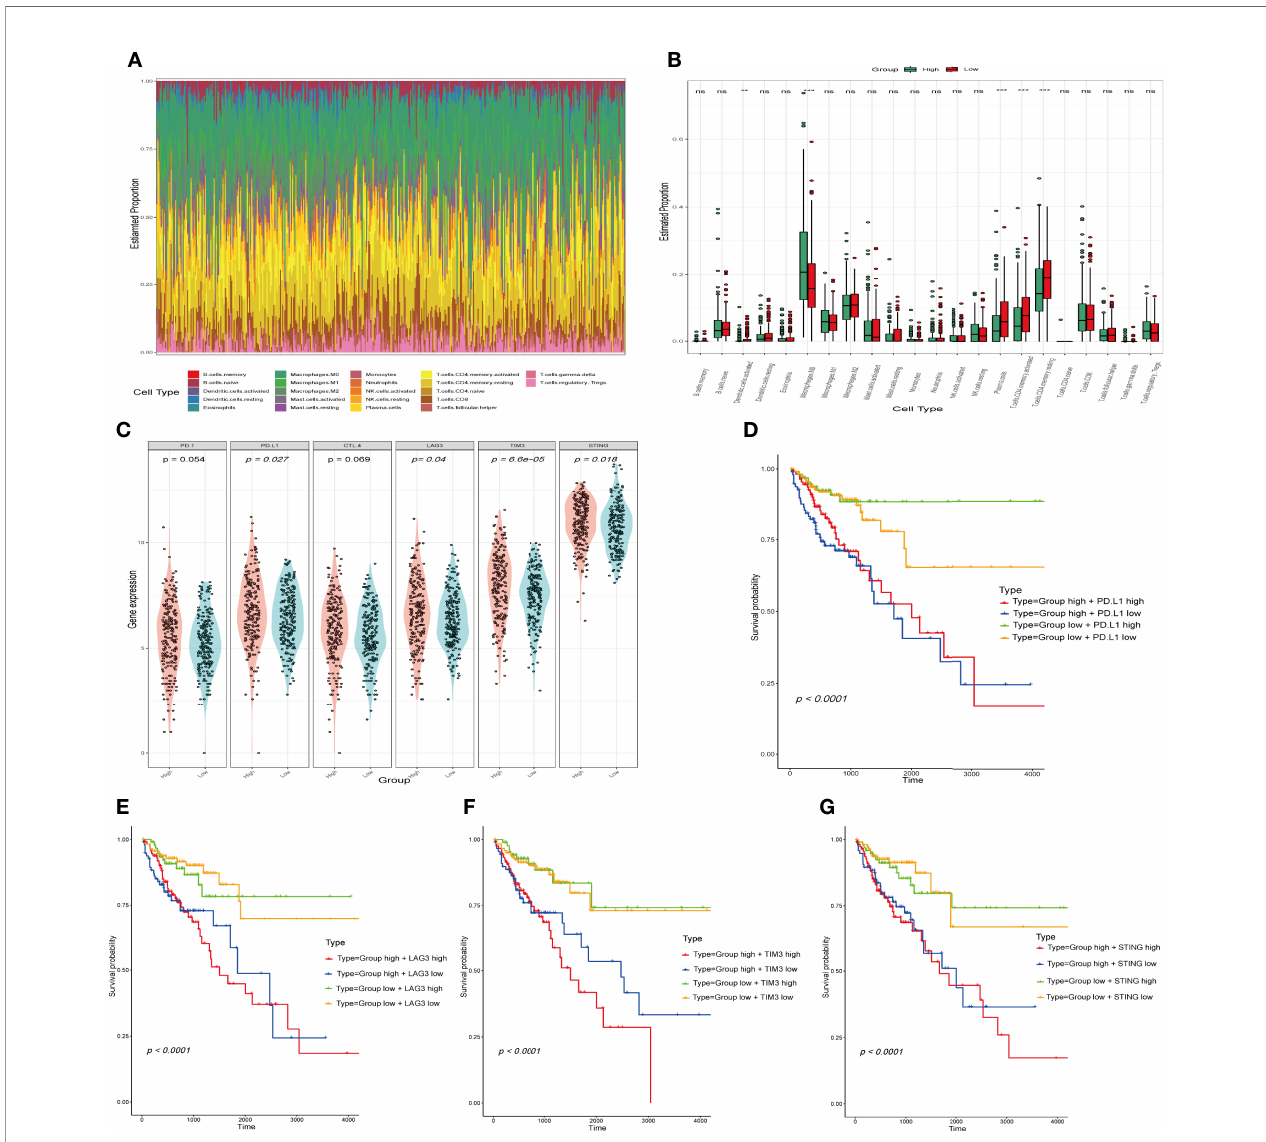
FIGURE 7 | Comparison of immune in fi ltration status and immune checkpoint gene expression between the high- and the low-risk groups. (A) Relative proportion of tumour ‐ in fi ltrating immune cells in all patients. (B) Differences in the in fi ltrating levels of 22 tumour-in fi ltrating immune cell types between the high- and low-risk groups by using the CIBERSORT algorithm. (** p < 0.01; *** p < 0.001; ns, not signi fi cant). (C) The expression of immune checkpoint genes in the high- and low-risk groups. The horizontal axis is the high and low risk group, the longitudinal axis is the expression of immune checkpoint genes. (D – G) Kaplan-Meier survival curves of overall survival among four patient groups strati fi ed by the IFN- g -related lncRNAs signature and PD. L1 (D) , LAG3 (E) , TIM3 (F) and STING (G)